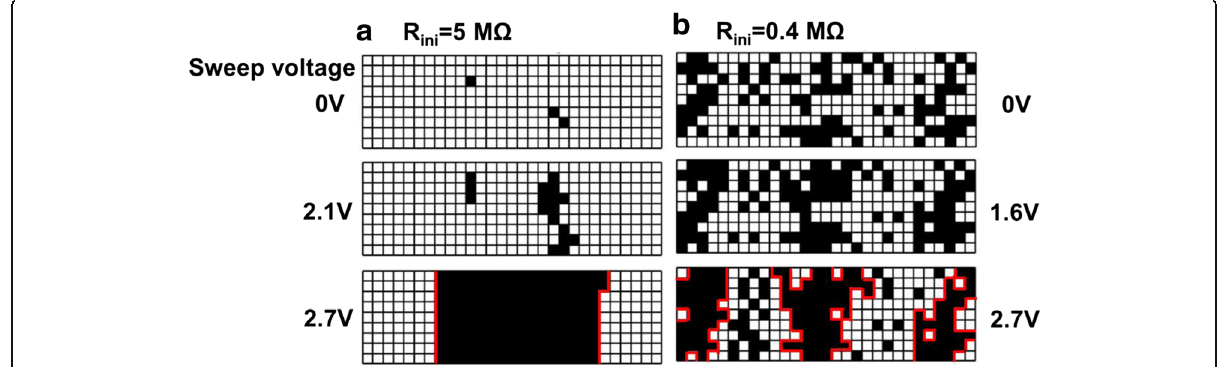
Fig. 10 Progress of CF in cell with a high initial resistance and b low initial resistance. Higher intrinsic Vo- concentration in the TMO layer results in Vo- randomly generation at weak spots. These Vo- also connect to each other to form dendritic paths